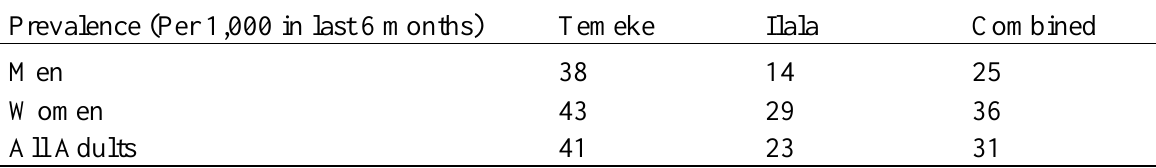
Table 2. Prevalence rates of any CMD by districts and